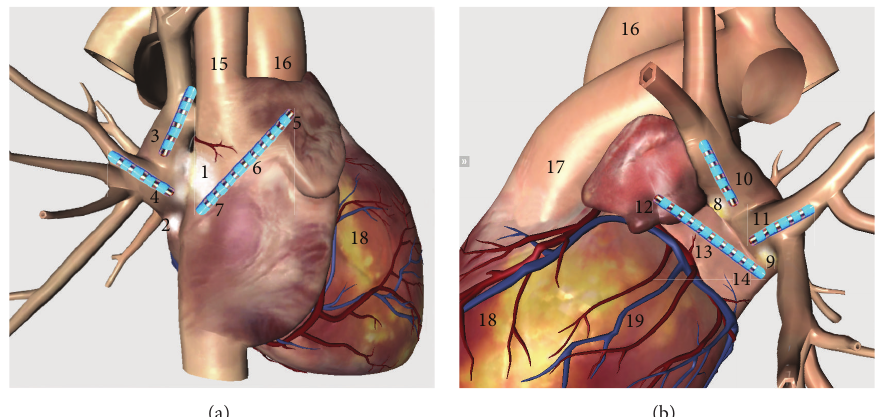
Figure 1: Position of catheters in the atrium. 1, anterior right ganglionated plexi (ARGP); 2, inferior right ganglionated plexi (IRGP); 3, right superior pulmonary vein (RSPV); 4, right inferior pulmonary vein (RIPV); 5, right appendages (RAA); 6, right atrium (RA); 7, margin of anterior right ganglionated plexi (ARGPM); 8, superior left ganglionated plexi (SLGP); 9, inferior left ganglionated plexi (ILGP); 10, left superior pulmonary vein (LSPV); 11, left inferior pulmonary vein (LIPV); 12, left appendages (LAA); 13, left atrium (LA); 14, Marshall ligament area (MSL); 15, superior vena cava (SVC); 16, aorta; 17, pulmonary artery (PA); 18, right ventricle (RV); and 19, left ventricle (LV).